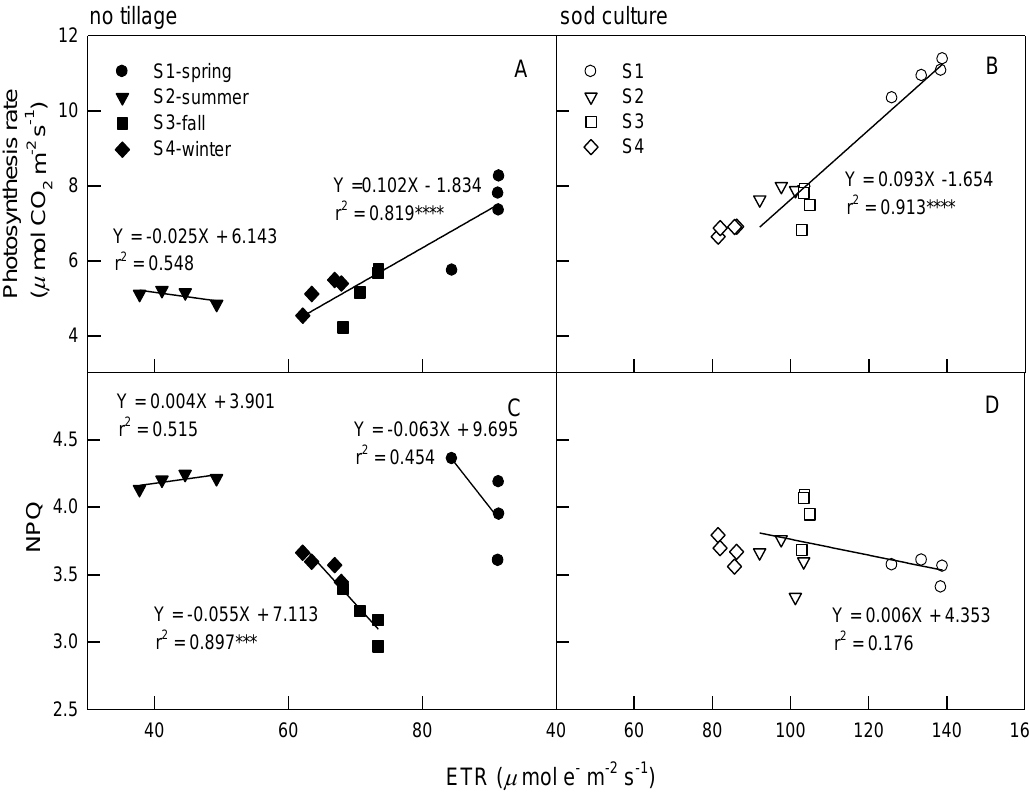
Figure 5. Correlations among ETR and Pn, NPQ of citrus grown in NT (panels A , C ) and SC (panels B , D ) in four seasons (S1–S4 respective to spring, summer, fall, and winter) monitored from June 2019 to May 2020. Plants were subjected to light irradiances at 1200, 1500, 1800, and 2000 μmol m −2 s −1 PPFD for 20 min. Each symbol represents the average of five leaves on one plant, and five plants were randomly selected from tillage and season treatments. Each line represents the time point of 16 values (four seasons multiplied by 4 PPFD) from model validation datasets. Correlation coefficients (r) are calculated and significance ( p ) is at the 0.0001 probability (****) level.